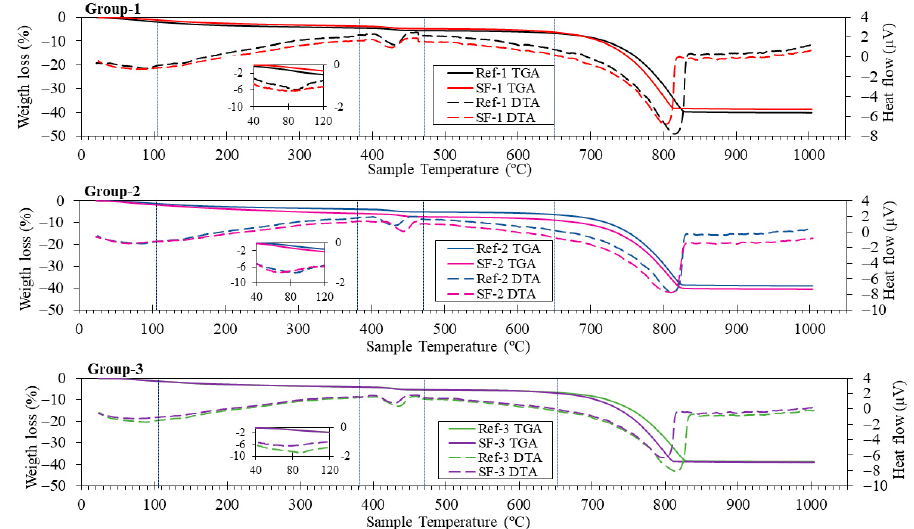
Figure 8. Thermogravimetric analysis (solid lines) and differential thermal analysis (dotted lines) for all groups of mixtures.